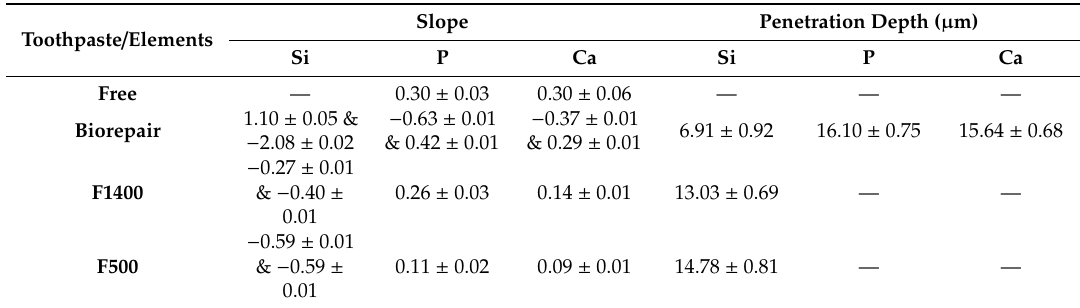
Table 1. Mean diffusion coefficient slope and penetration depth extrapolated by linear and non-linear regression of the atomic content curves.